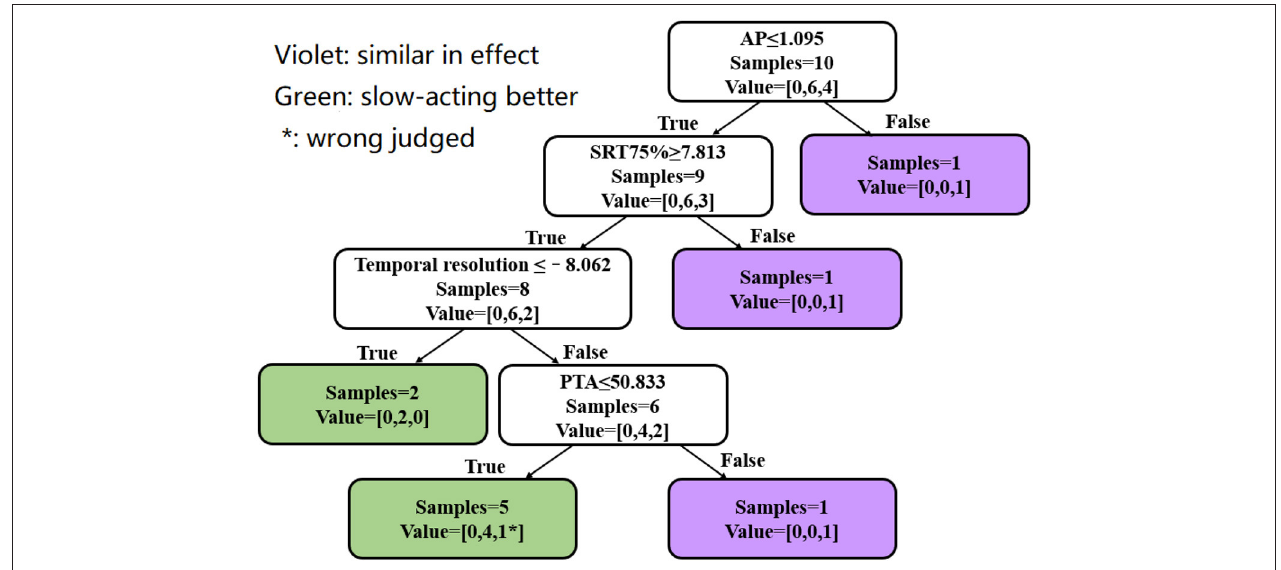
FIGURE 8 | Verification of the decision tree model. Violet represents a similar aided SRT75% between the two compression speeds. Green represents better SRT75% for SAC than FAC. “*” Represents a subject who was judged incorrectly. Value = [A, B, C]: A is the number of subjects who performed better with FAC, B is the number of subjects who performed better with SAC, and C is the number of subjects where performance between FAC and SAC was similar.